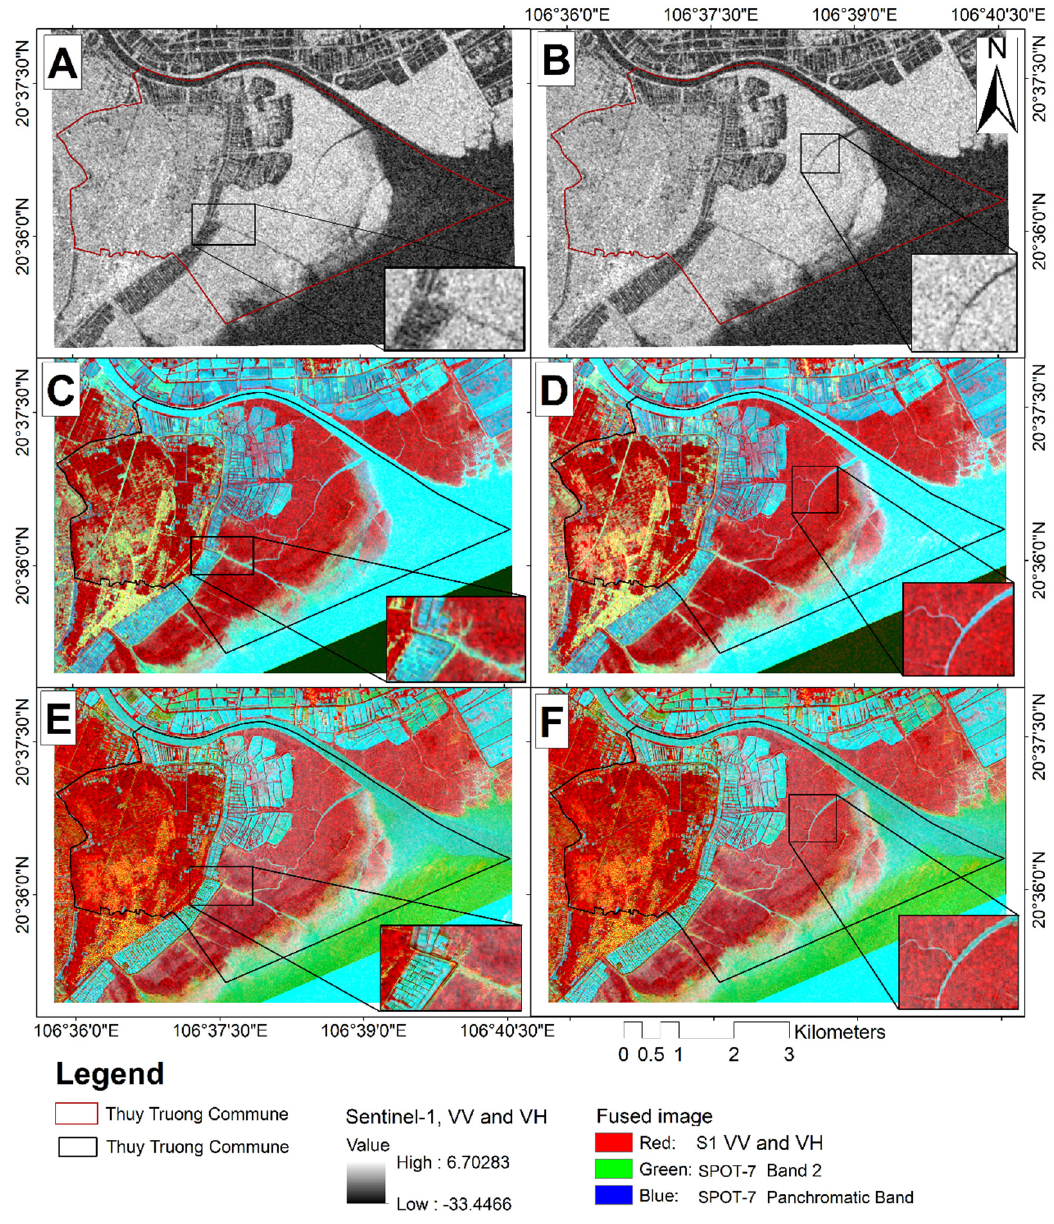
Figure 5. Demonstrations of SPOT-7 and Sentinel-1 (S1) image fusion processes where ( A ) is the original Sentinel-1 VH layer and ( B ) is Sentinel-1 VV layer (sigma0 in decibel); and ( C – F ) depict the results of the fused images using VH–GS, VV–GS, VH–PCA, and VV–PCA, respectively.